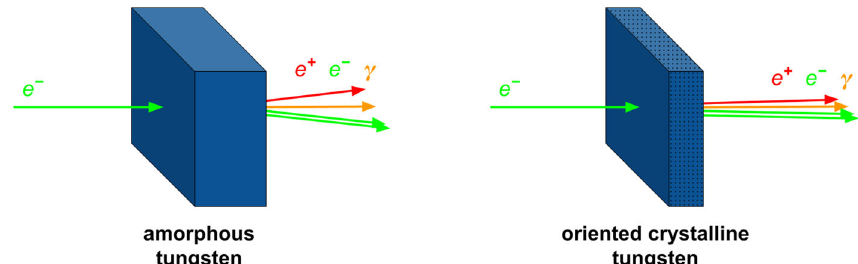
Fig. 1 Single-target